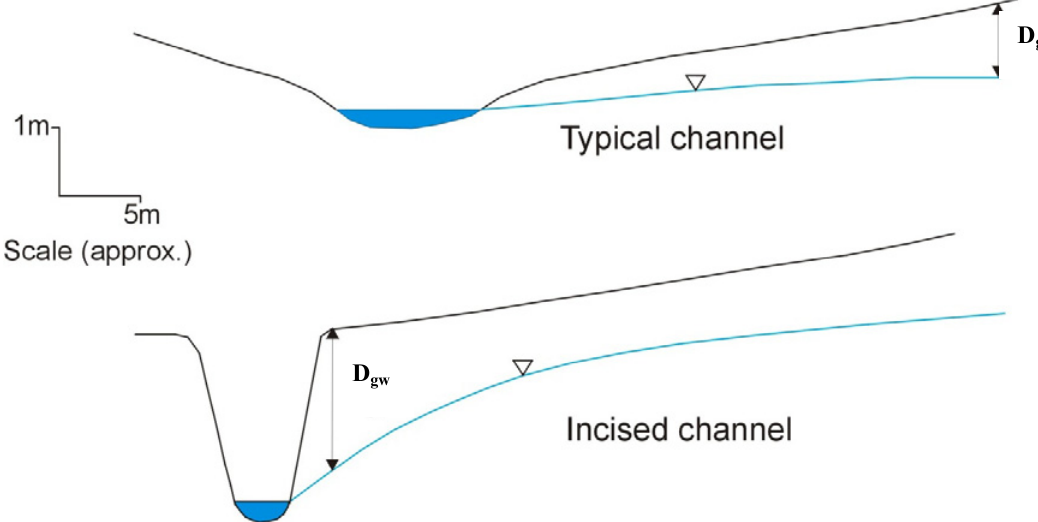
) in a typical floodplain and gw is greatest near the incised gw